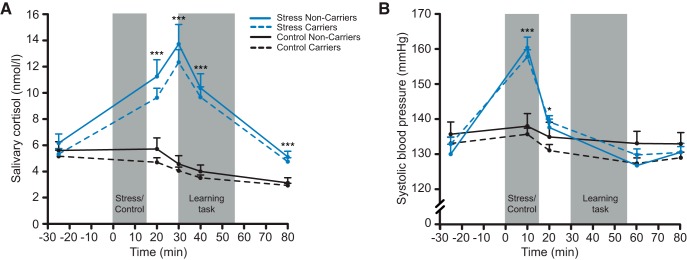
Physiological data of Experiment I. Independent of the MR haplotype and compared to a nonstressful control manipulation, exposure to the TSST led to significant increases in (A) salivary cortisol concentrations and (B) systolic blood pressure. ***p < 0.001, *p < 0.05, error bars represent SEM.